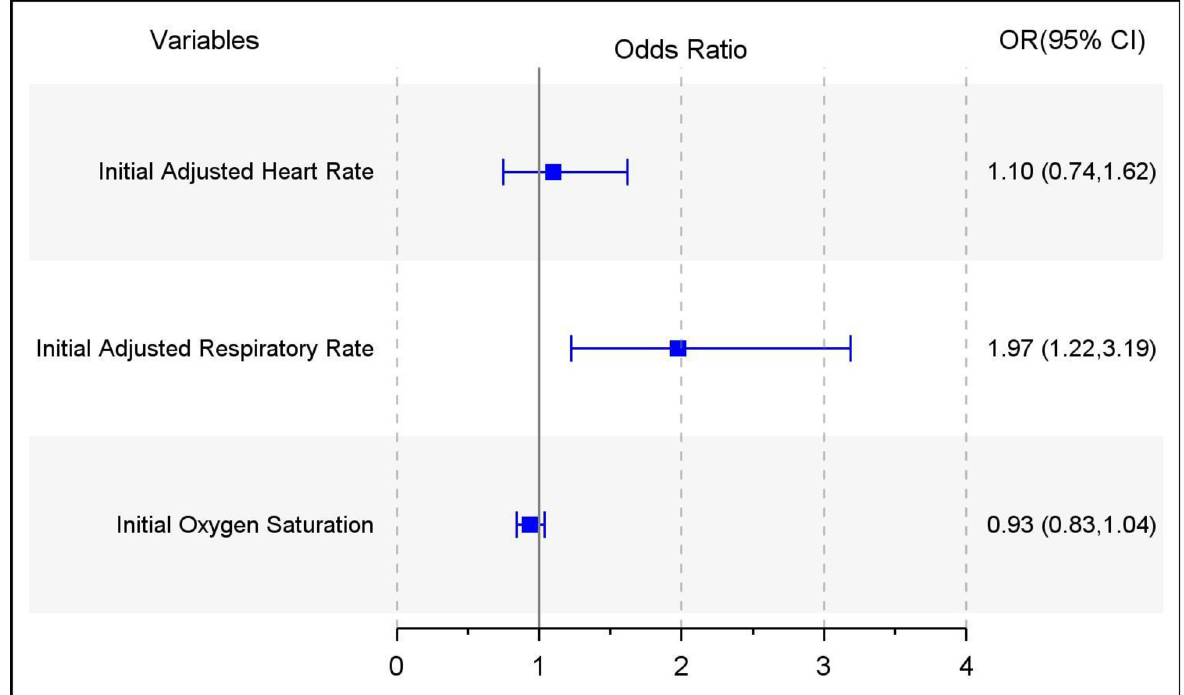
Fig 1. Odds of hospitalization and recurrent ED visits among children with PCR-confirmed influenza using vital sign data as clinical predictors, model adjusted for age, high risk co-morbidities, school or daycare attendance.